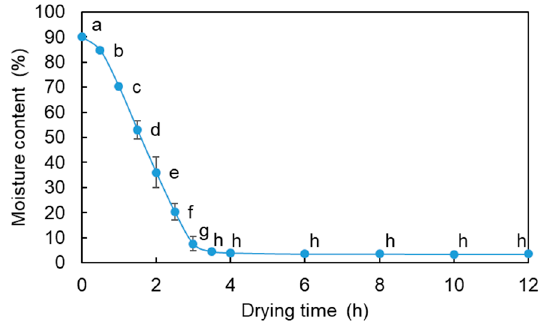
Figure 1. Moisture content of L. edodes at different drying times. Means with different letters are significantly different from others ( p < 0.05).